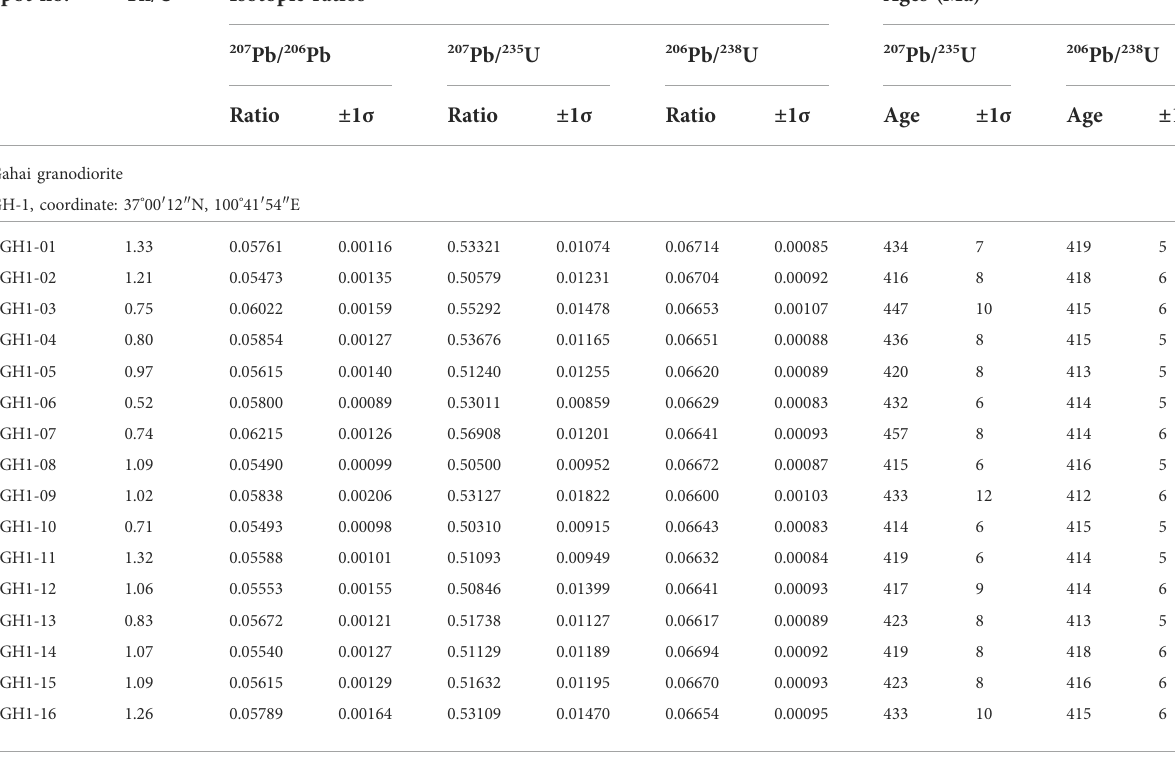
TABLE 1 LA – ICP – MS zircon U – Pb dating results of representative samples from the Gahai and Erhai plutons. Spot